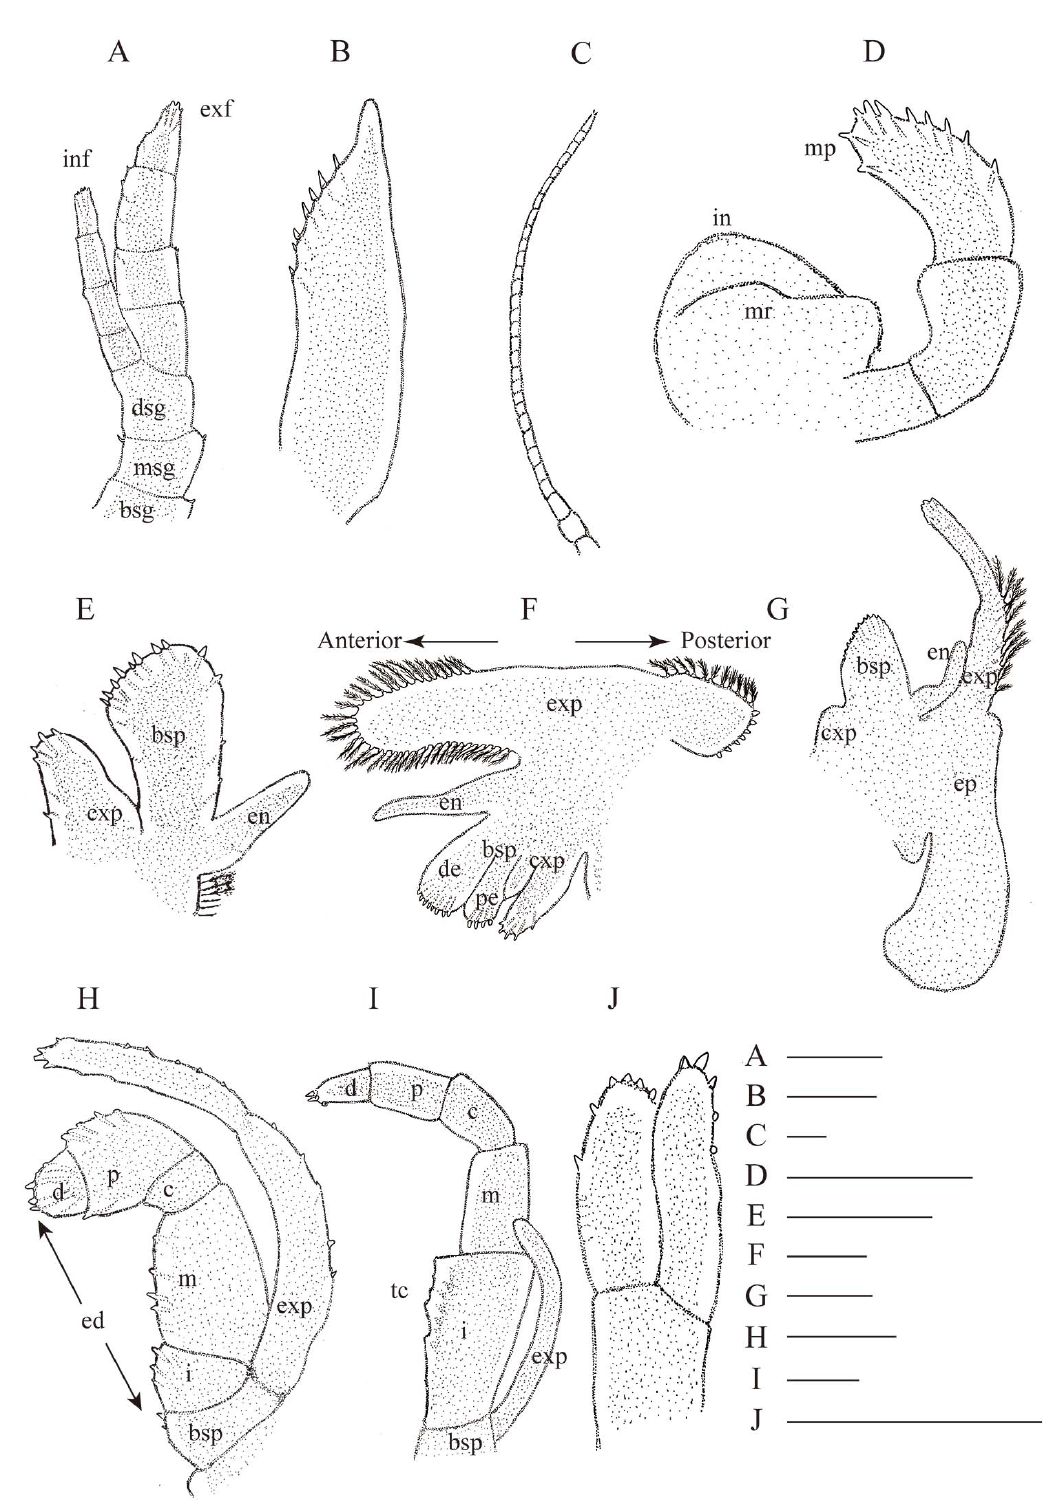
Figure 2. Juvenile Stage I of Austropotamobius torrentium . ( A ) Antenna 1, dorsal view; ( B ) antennal scale, dorsal view; ( C ) antenna 2, dorsal view; ( D ) mandible, view of inside of mouth; ( E ) maxilla 1, oral view; ( F ) maxilla 2, oral view; ( G ) first maxilliped, oral view; ( H ) second maxilliped, oral view; ( I ) third maxilliped, oral view; ( J ) pleopod. bsg, basal segment of peduncle; bsp, basipodite; c, carpopodite; cxp, coxopodite; d, dactylopodite; de, distal endite; dsg, distal segment of peduncle; ed, endopodite; en, endite; ep, epipodite; exp, exopodite; exf, external flagellum; i, ischiopodite; in, incisor ridge; inf, internal flagellum; m, meropodite; mp, mandibular palp; mr, molar ridge; msg, intermediate segment of peduncle; p, propodite; pe, proximal endite; tc, toothed crest. Scale bars: 0.25